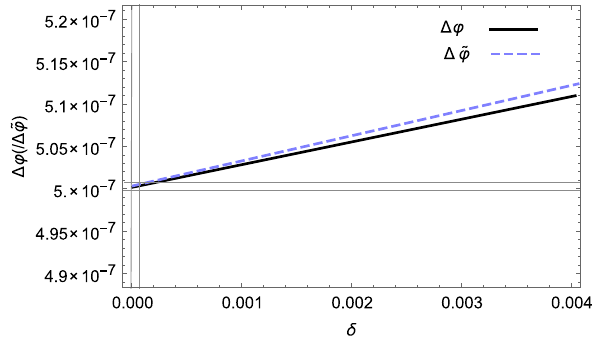
Fig. 7 The plot shows the behaviour of perihelion shifts for δ < 1 > 1. The solid (Black) curve shows that (cid:24)ϕ increases with with r r c increasing values of δ , whereas (cid:24) ˜ ϕ (the dashed curve) increases more rapidly in contrast to the solid (Black) curve w.r.t. smaller δ . The narrow vertical strip corresponds to the allowed smaller values of δ required for conformalequivalence,whereasthehorizontalnarrowstripcorresponds to the observed values [80–83,94,95]